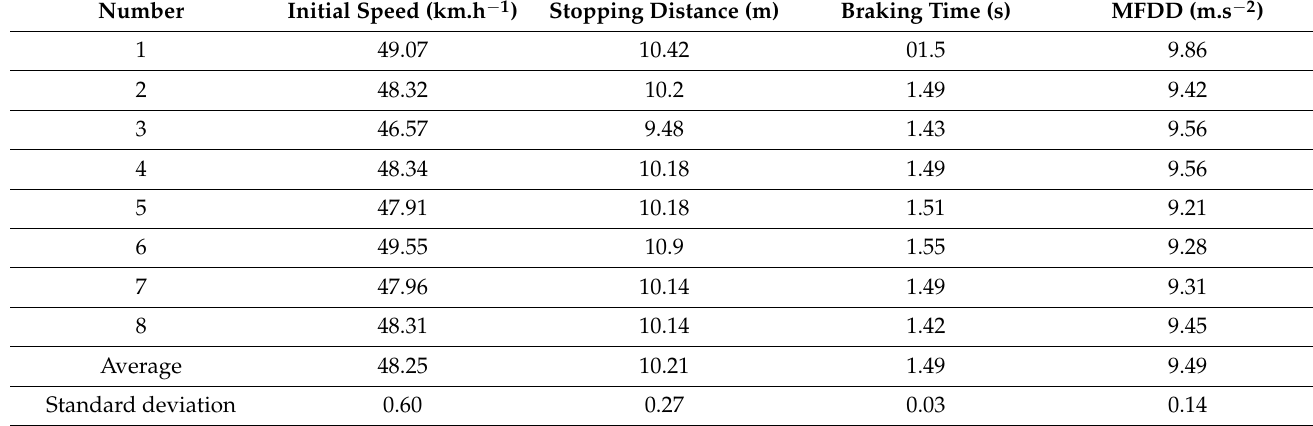
Table 9. Braking characteristics measured with low-priced brake components.